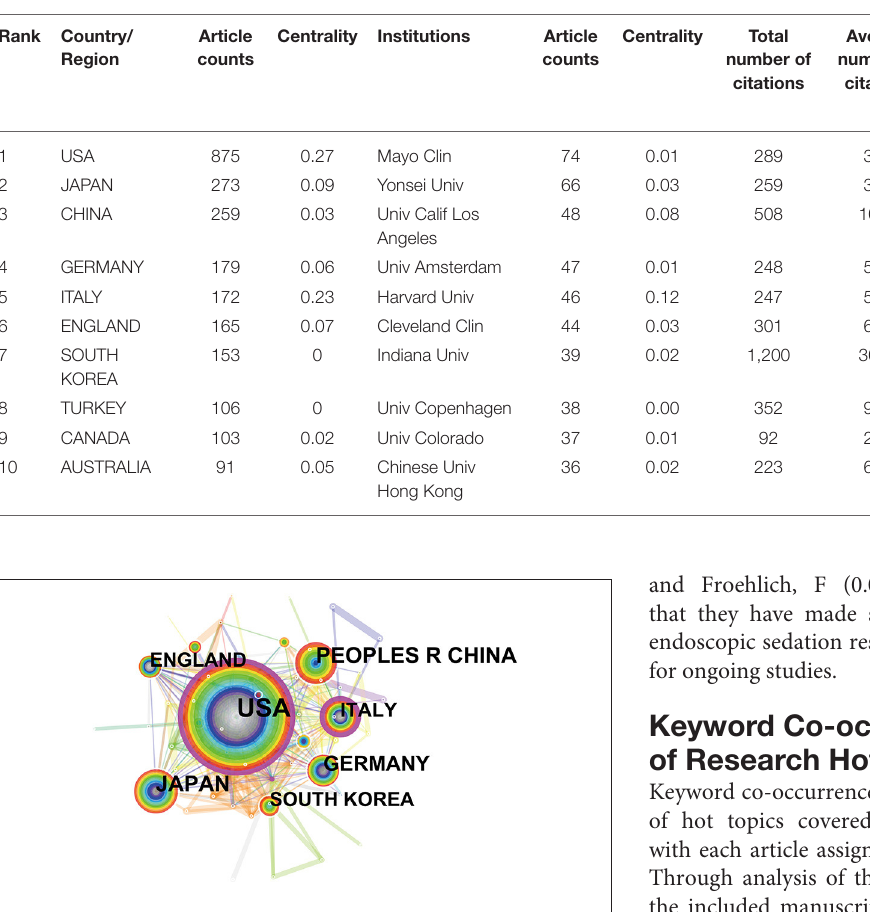
FIGURE 2 | The network map of countries involved in Endoscopic Sedation